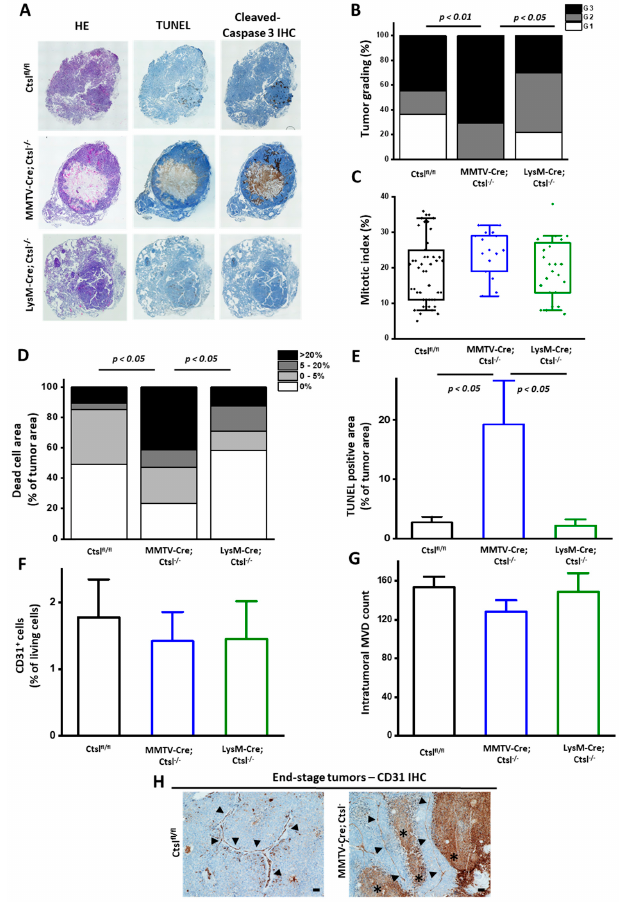
Figure 2. Ctsl knockout in mammary epithelial tumor cells causes tumor dedifferentiation. ( A ) Hematoxylin and eosin (HE) and TdT-mediated dUTP-biotin nick end labeling (TUNEL) staining, as well as cleaved caspase 3 immunohistochemistry (IHC), on end-stage tumors. HE and TUNEL are further quantified in panels B–C of this figure. Caspase 3 IHC is a representative image of 6 tumor specimens analyzed per genotype. Single images were recorded at 4× magnification, and at least 6x6 frames were stitched together to images depicting whole tumors in an automated manner by the Keyence software. ( B ) Blinded histopathological grading of HE stained tumor sections. Grade I (G1), well differentiated carcinoma; grade II (G2), moderately differentiated carcinoma; grade III